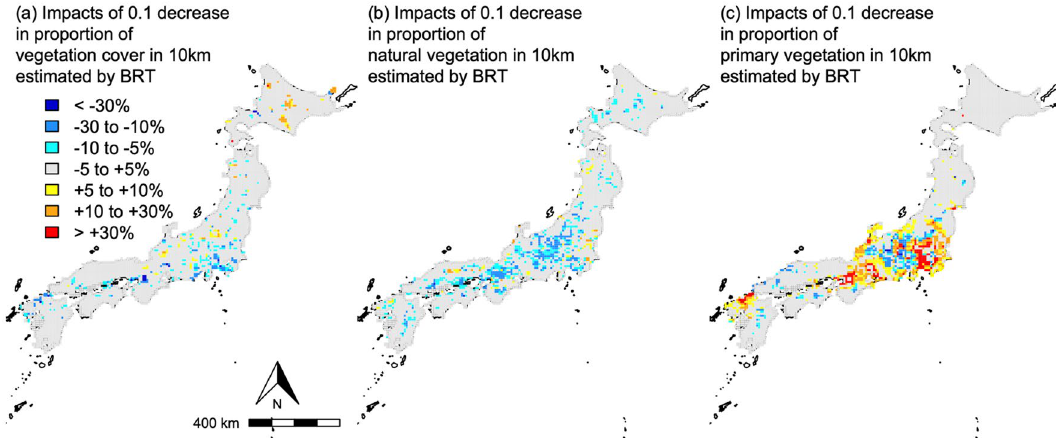
Figure 5. Expected impacts of 0.1 decrease in the three vegetation variables on total number of hiking records. ( a ) Impacts of loss in vegetation cover, ( b ) proportion of natural vegetation, and ( c ) proportion of primary vegetation. For maps of each month, see Figs. S1–3. The maps were drawn using R 4.1.1 software package 29 with public data of the border (https:// www. gsi. go. jp/ kanky ochiri/ gm_ jpn. Grid squares. Records of hiking activity were summarized for 4244 secondary grid squares based on Stand- ard Grid Square System, which was defined by the Minister’s Order of Administrative Management Agency in 1973. In the system, the secondary grid was defined as a grid of 5 ′ in latitude and 7 ′ 30 ″ in longitude, which roughly corresponds to a 10 km grid in the study area. This is the standard grid system of the government and we adopted the system for convenience in future application uses and communication with practitioners. The grids, which are defined by latitude and longitude, are different in the area up to 22% between the north and south ends. Therefore, area of each grid was included in a model as an offset term. Hiking activity.